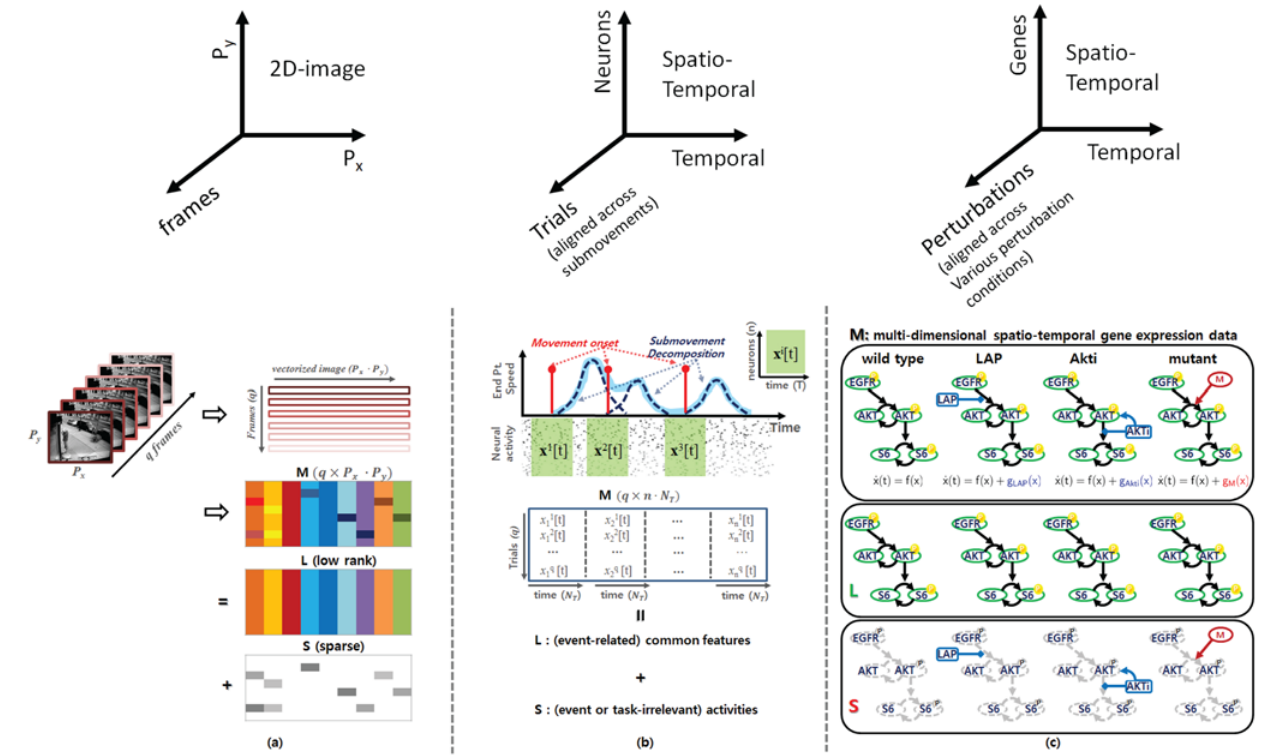
Fig 2. Conceptual representation. (a) RPCA applied to computer vision. A typical example of video surveillance where the low-rank component represents the unchanging background and the sparse component represents the movements in the foreground. (b) RPCA applied to neural systems. The low-rank component putatively represents (submovement relevant) neural signatures and the sparse component represents neural activity unrelated to submovement onset. (c) Collections of drug-induced perturbation experiments and mutant-specific part representations (breast cancer signaling pathway) with wild-type , Lapatinib treatment, AKT inhibitor and mutant cell lines where solid black edges represent common network topology, and blue and red edges represent a single change of the network topology for perturbations or mutant cell lines.